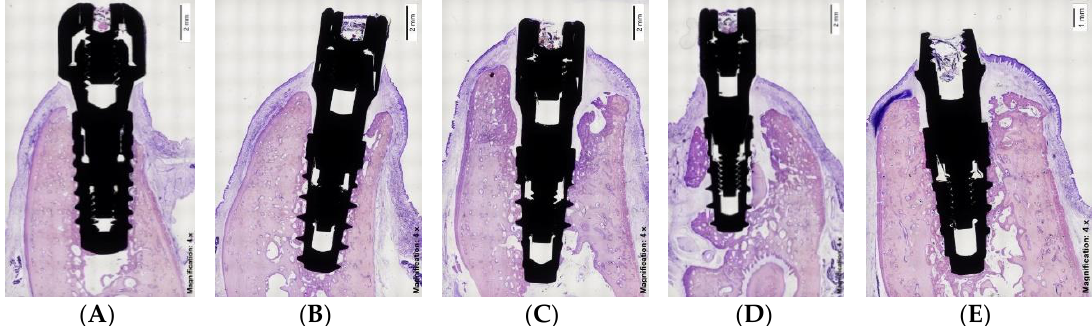
Figure 3. Histological images of immediate implants. ( A ) Straumann BL; ( B ) IPX-Std; ( C ) IPX-Half; ( D ) IPX-Full; ( E ) IPX-Control.